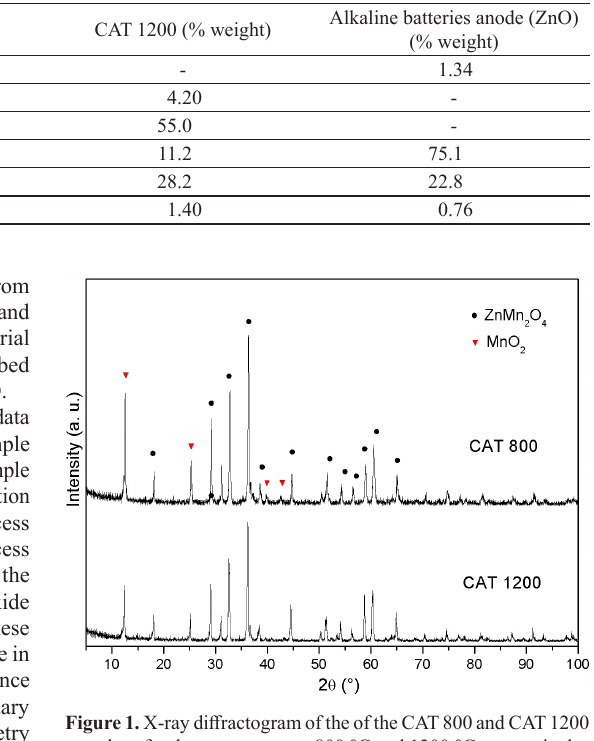
Table 1. Elemental chemical composition determined by wavelength dispersive X-ray fluorescence (WD-XRF), in % weight, of the CAT 800 and CAT 1200 samples after heat treatment at 800 °C and 1200 °C, respectively. Results for zinc oxide recovered from the alkaline batteries’ anodes are also shown.